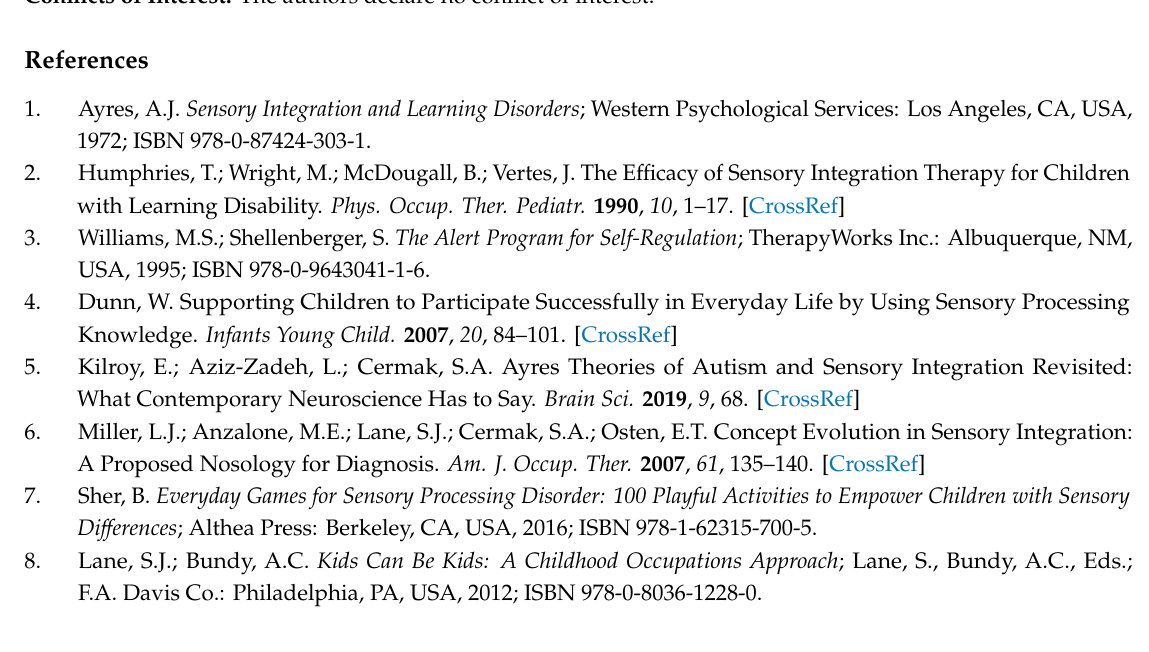
Table S1: Behavioral Observation on Sensory Stimuli Questionnaire for Parents (BOSS-P) Versi ó n original española: Cuestionario de Observaci ó n de la Conducta ante Est í mulos Sensoriales para Padres de niños / as y adolescentes con Autismo / TEA